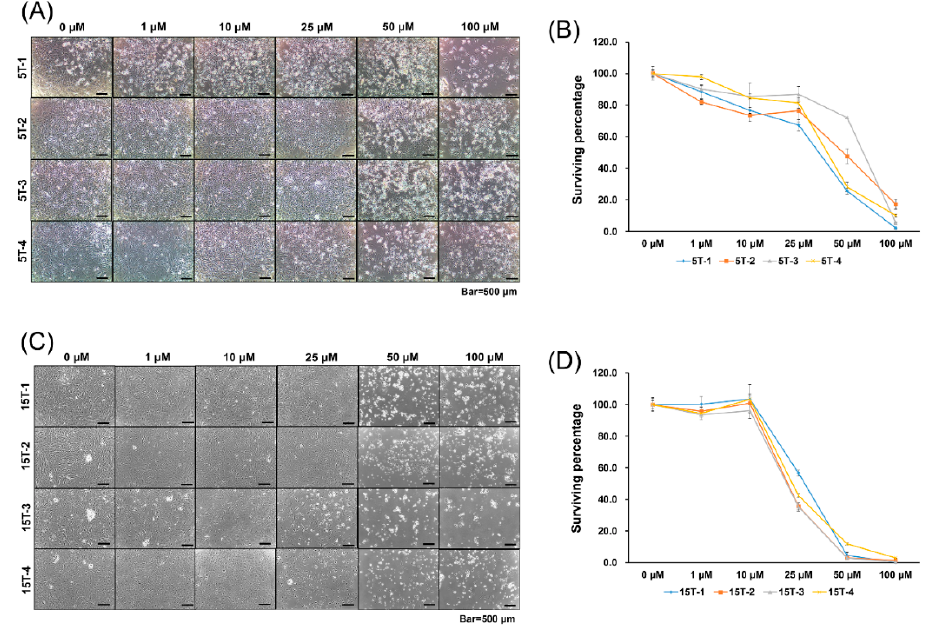
Figure 1. Cytotoxicity assay of 18 α -glycyrrhetinic acid (AGA) and T0070907. Representative microscopic images of tendon-derived stem cells (TDSCs) cultured with various concentrations of ( A ) AGA and ( C ) T0070907. 5T-1, 5T-2, 5T-3, and 5T-4 stem cells were collected from different rat specimens as 5-week-old, chemically induced tendinopathy donors. In the same manner, 15T-1, 15T- 2, 15T-3, and 15T-4 cells were collected from different rat specimens as 15-week-old, injury-with- overuse tendinopathy donors. TDSCs were cultured with various concentrations (0, 1, 10, 25, 50, 100 μ M) for 5 days. Cytotoxicity of ( B ) AGA and ( D ) T0070907 was measured by Cell Counting Kit (CCK)- 8 assay. The optimal dose of AGA and T0070907 killing less than 50% of TDSCs was 25 μ M and 10 μ M, respectively. In (b,d), error bars represent the standard deviation of mean.